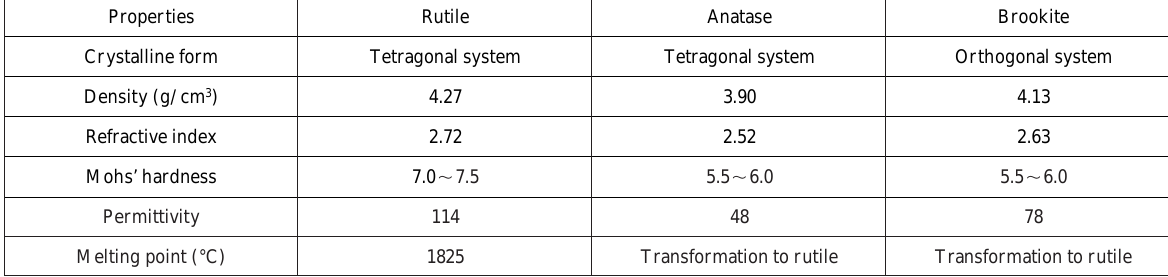
Table 1 Types and physical properties of titanium